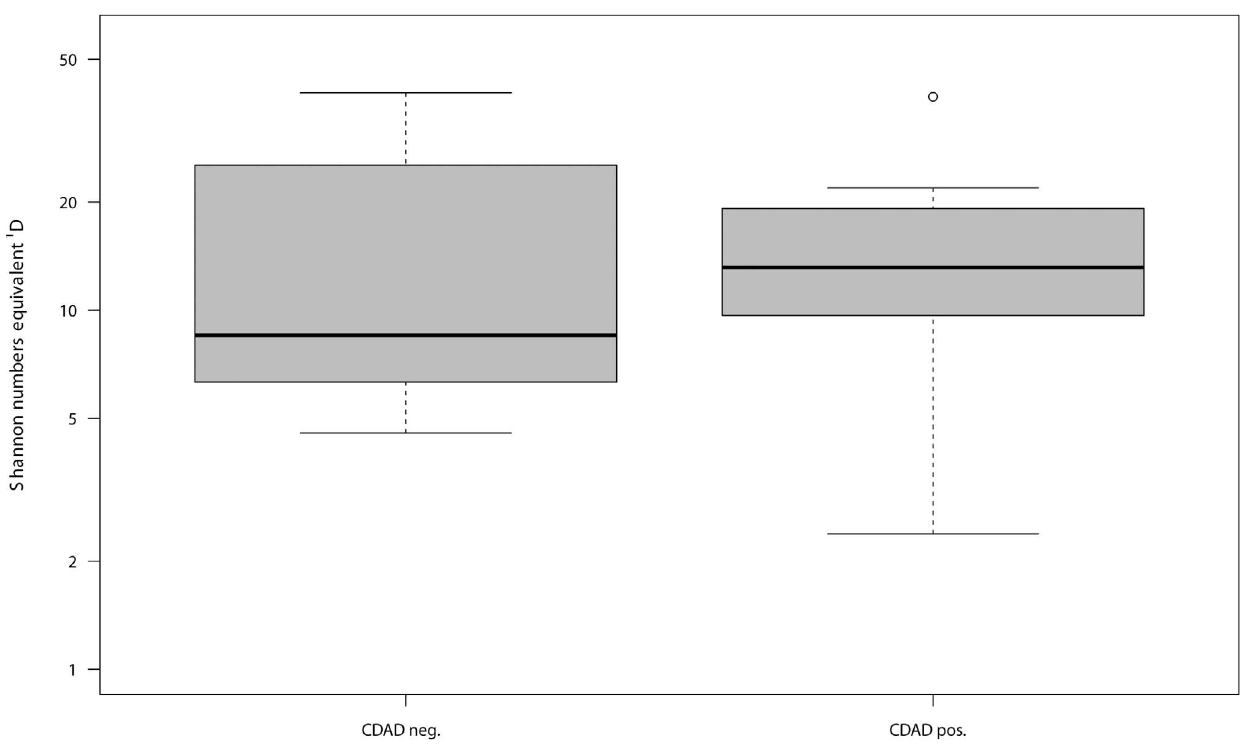
Figure 2. Distribution of Shannon number equivalents at RNA level concerning CDAD positive and CDAD negative individuals.